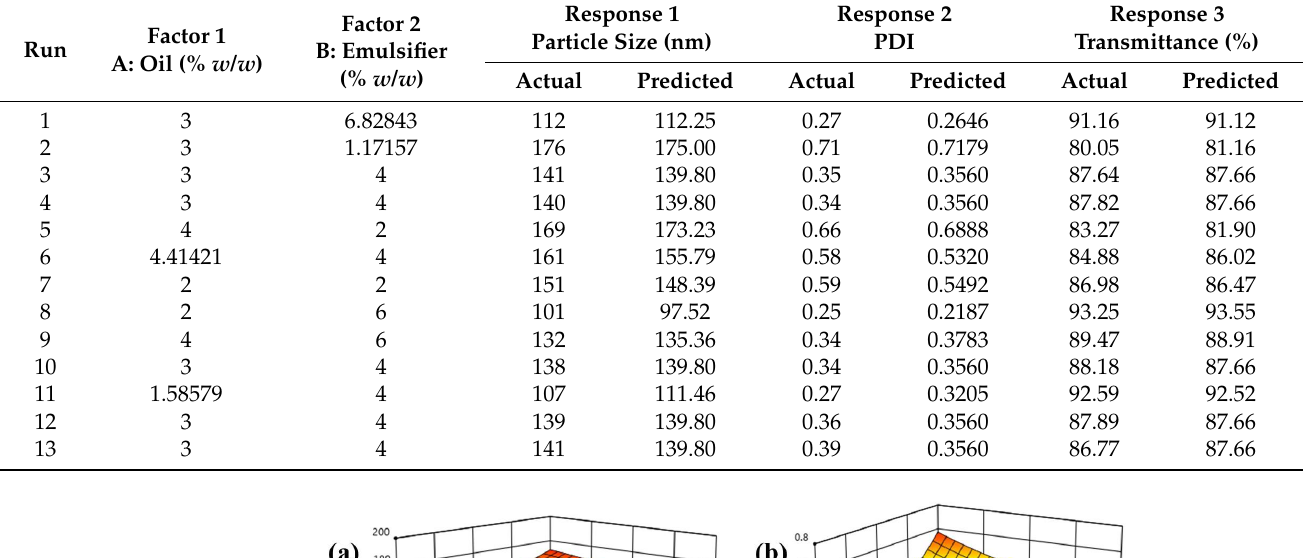
dimensional graph (Figure 2) exhibits the effects of independent variables on dependent variables. Table 1. Selected independent variables for the optimization of lidocaine-loaded nanoemulsion us- ing CCD.